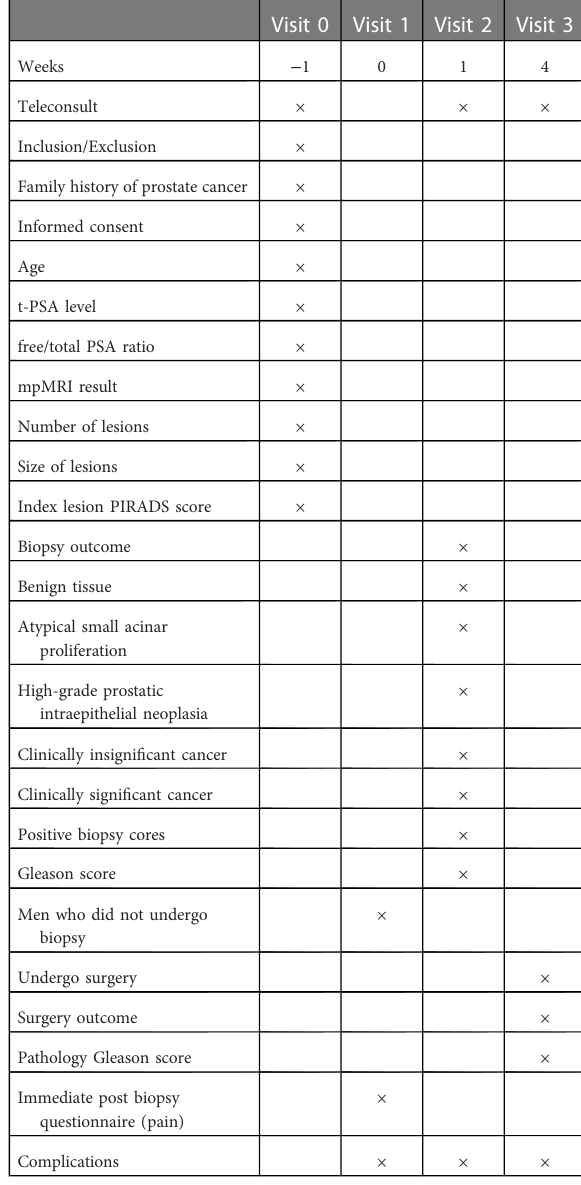
TABLE 1 Schedule of